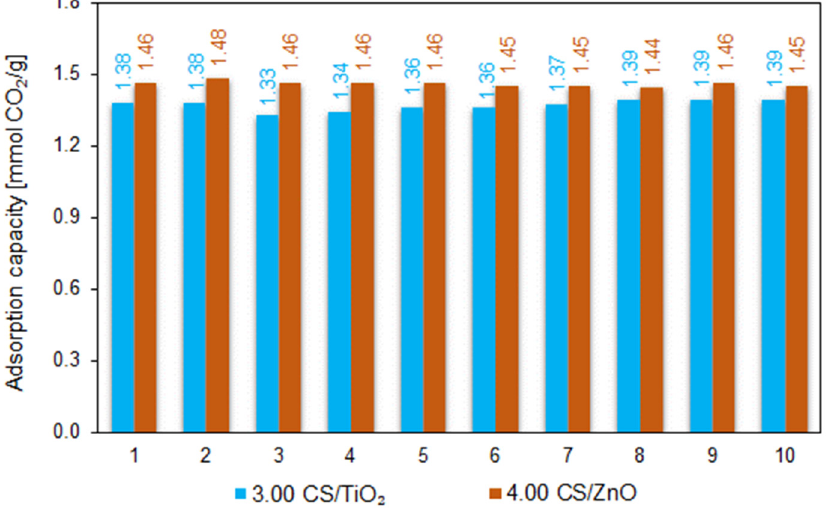
Figure 8. Multicyclic stability of CO 2 adsorption–desorption measured at 30 °C for 4.00 CS/TiO 2 and 3.00 CS/TiO 2 samples.